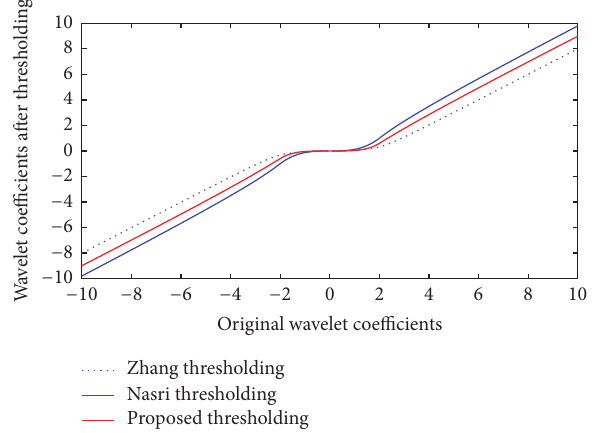
Figure 3: Comparison with Zhang’s and Nasri’s thresholding func- tions.